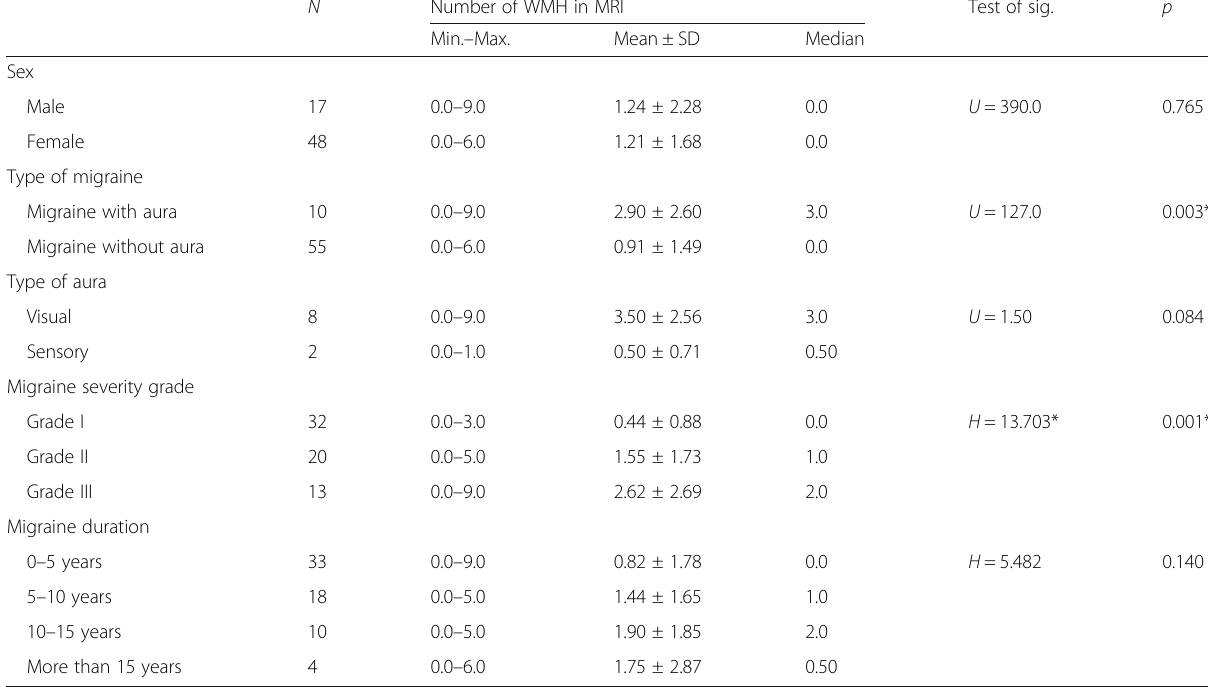
Table 3 Relation between number of white matter hyperintensities in MRI and sex, migraine type, severity, duration and type of aura N Number of WMH in MRI Test of sig.